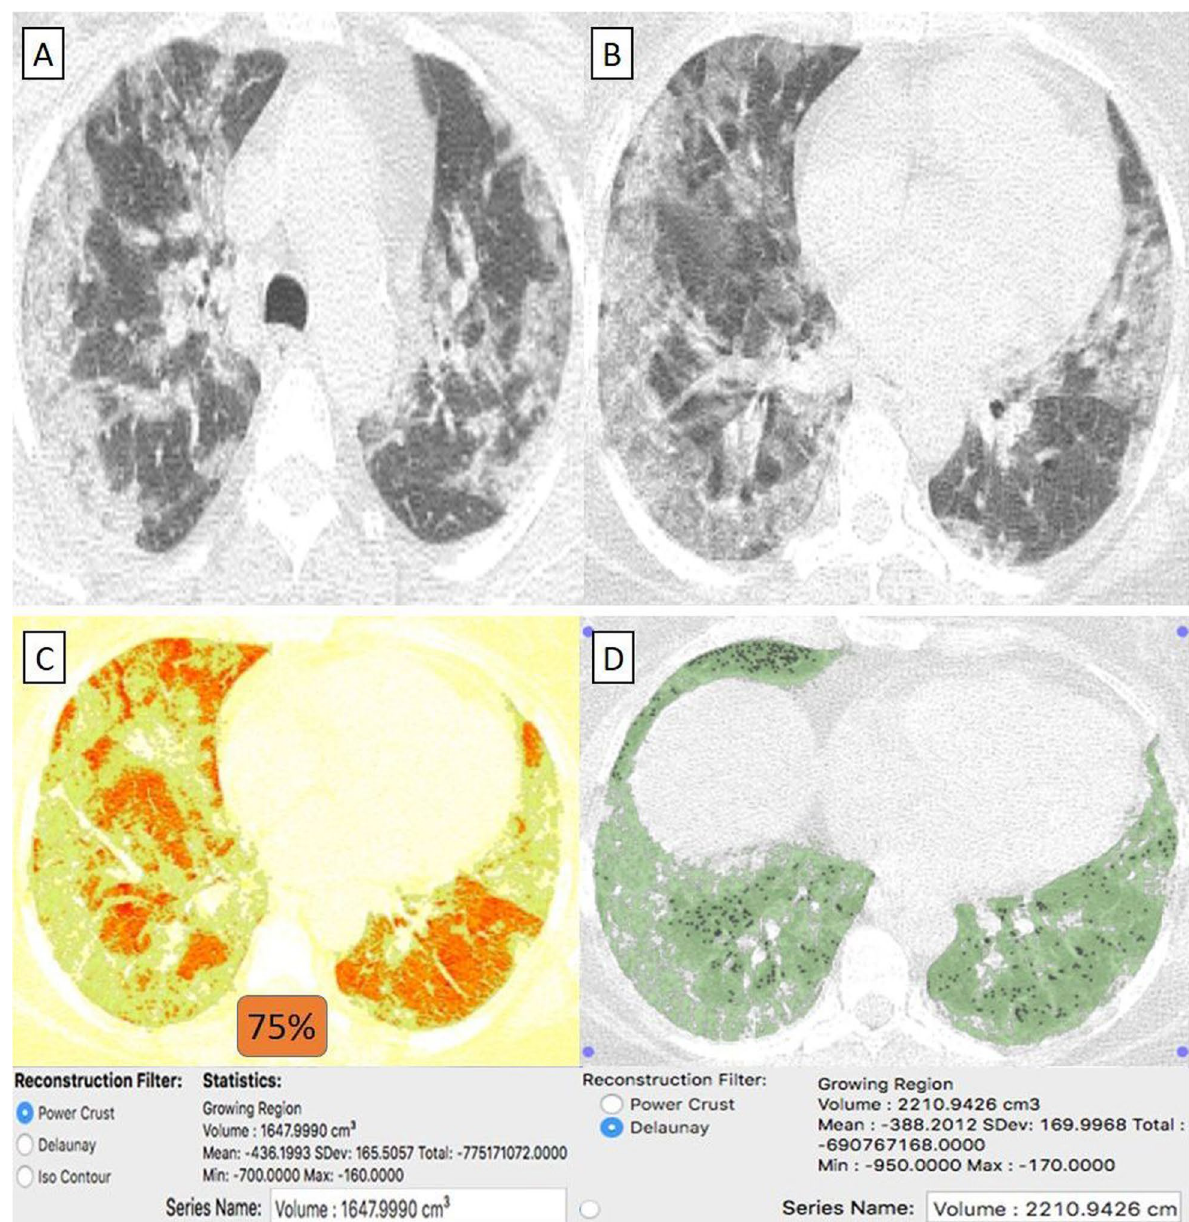
Fig. 7 A 55‑year‑old female patient with history of systemic lupus erythematosus (SLE) and had received “Sinopharm” vaccine then got COVID‑19 infection. A , B Axial chest CT cuts (lung window) showed bilateral mainly peripheral located wide spread ground‑glass pneumonic patches. C CT‑Volumetry of the pathological lung parts averages 1647 cc. D CT‑Volumetry of total lung volume averages 2210 cc. So, 75% of the lung parenchyma was diseased (Score